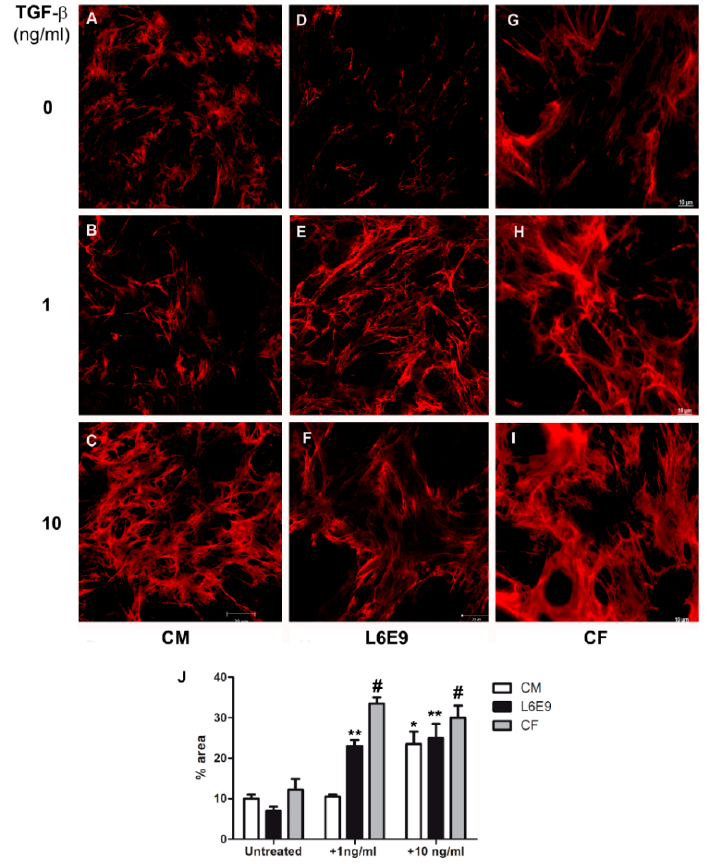
Figure 1. Transforming growth factor beta (TGF- β ) differentially modulates fibronectin (FN) in cardiomyocytes, skeletal myoblasts L6E9, and cardiac fibroblasts. ( A ) Normal cardiomyocytes showed FN fibrils on surface. The addition of 1 ng/mL of TGF- β ( B ) did not alter the FN expression